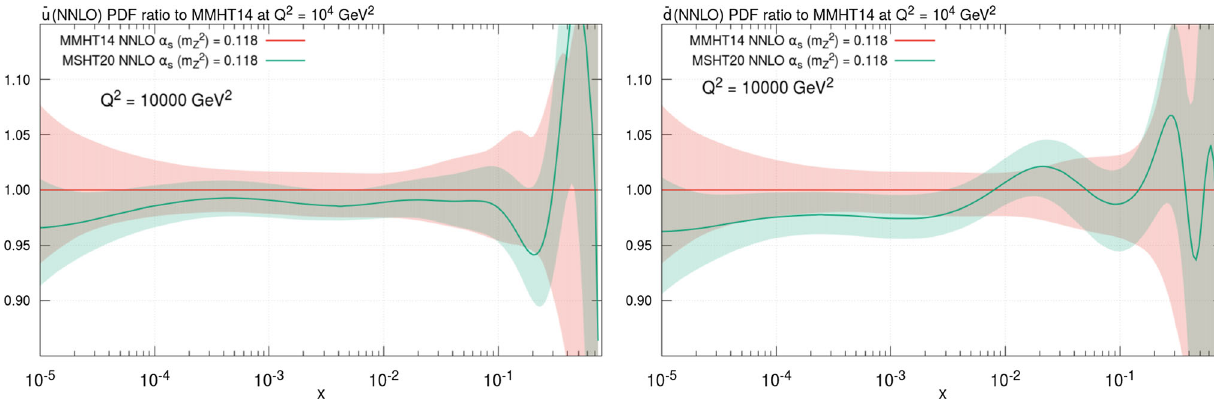
Fig. 20 Ratio of (left) Up antiquark and (right) Down antiquark PDFs to MMHT14, at NNLO and Q 2 = 10 4 GeV 2